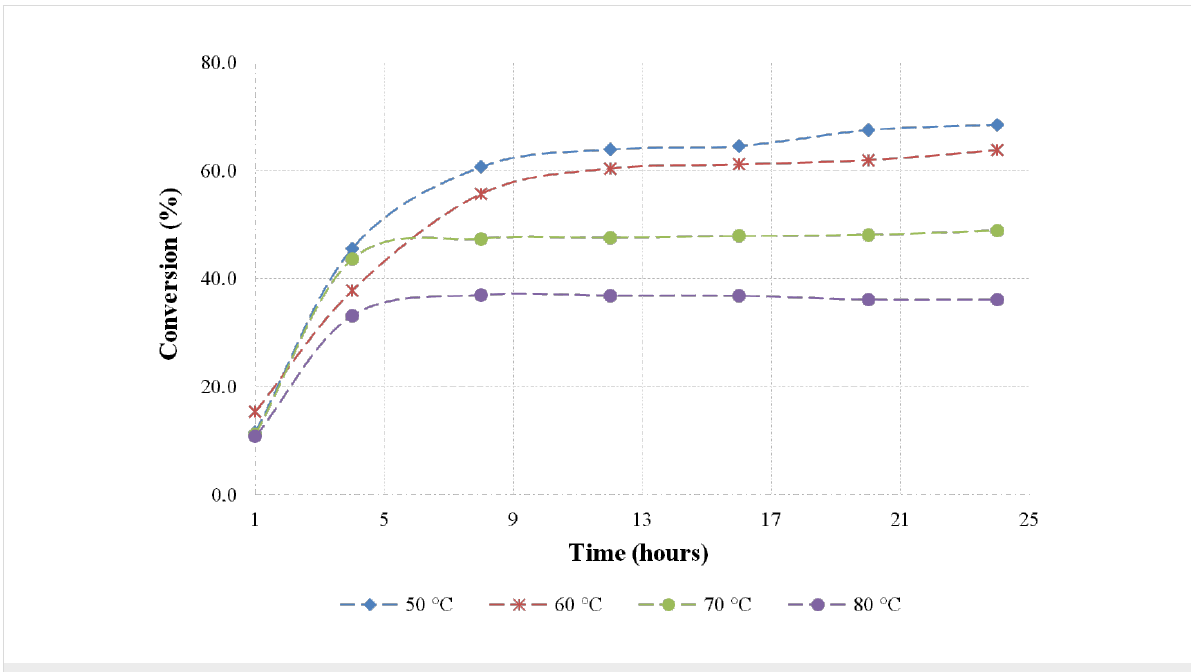
Figure 1: PMD conversion using stoichiometric quantities of acetic anhydride.